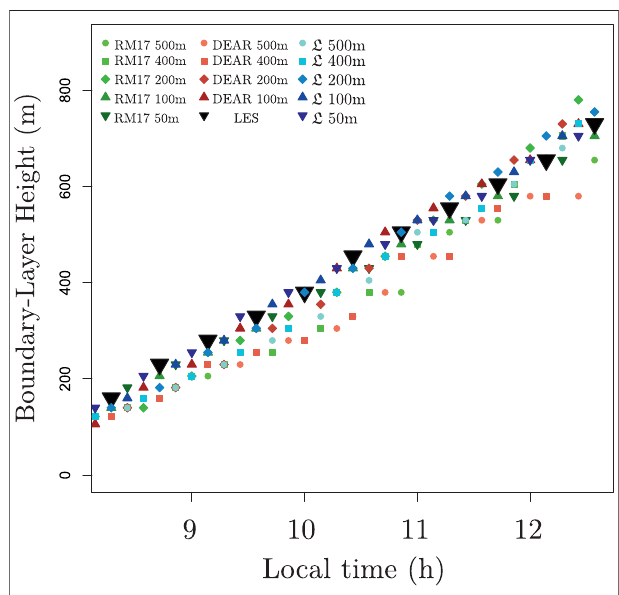
FIGURE4 | Timeevolutionoftheboundary-layerheightfortheIHOPcase run with RM17, DEAR and L at 50, 100, 200, 400, and 500 m grid spacing.